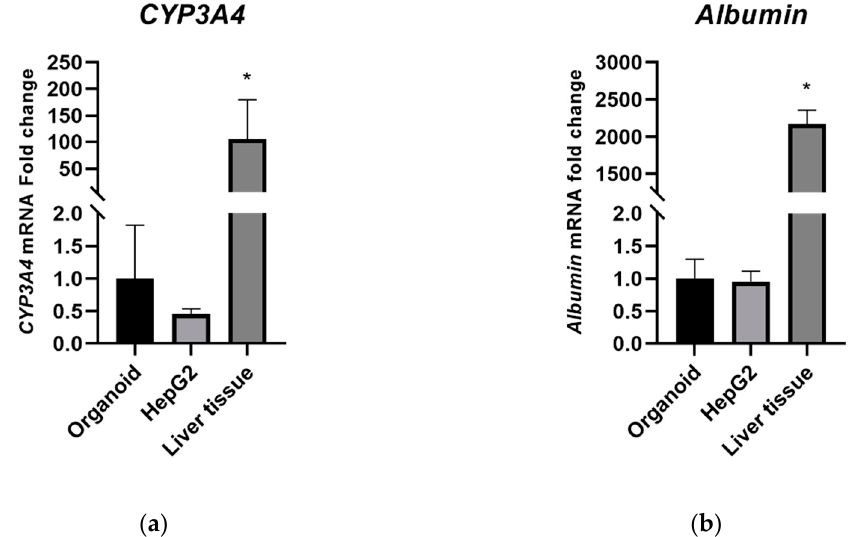
Figure 2. CYP3A4 and albumin mRNA expression in organoid and HepG2 cells. ( a ) 2-dCt values of CYP3A4; ( b ) 2-dCt values of albumin. Data are shown as a mean ± standard error; * p < 0.05. The experiments were performed in triplicate, each being repeated at least three times.